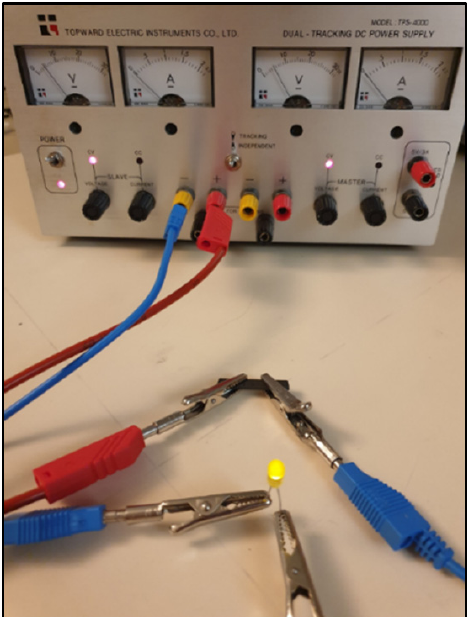
Figure 15. The variation of the electrical volume resistivity of the composites as a function of the percentage of M5 GNP.